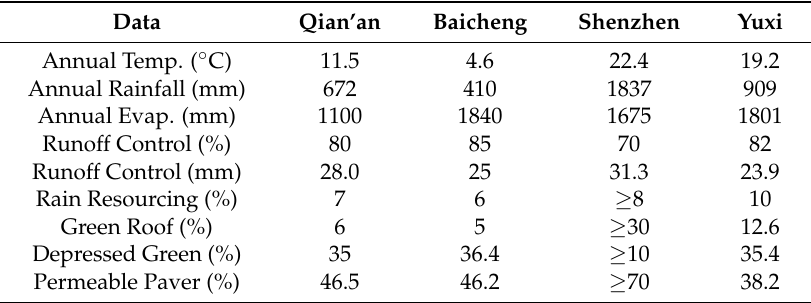
Table 2. LID strategies for various